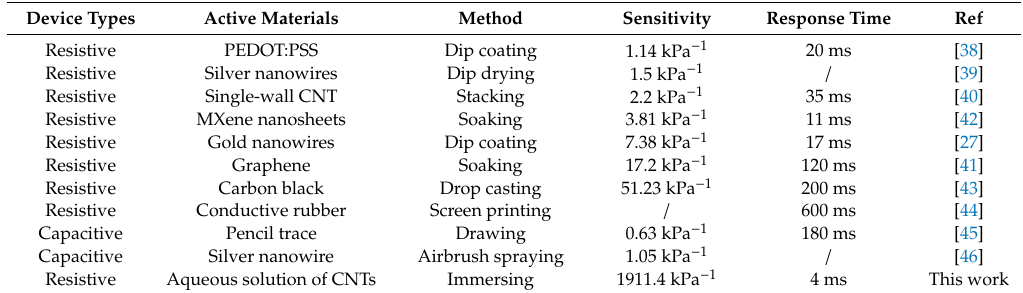
Table 1. Comparison of all research studies about paper-based pressure